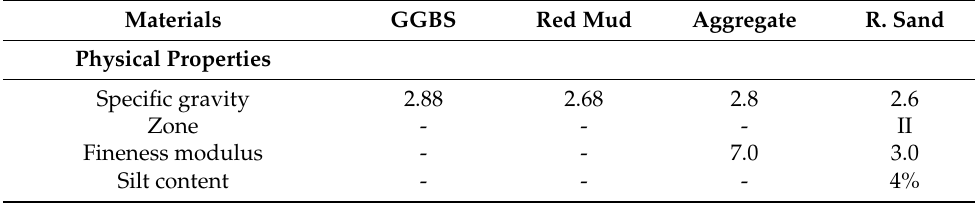
Table 2. Physical properties of ingredients of GPC.